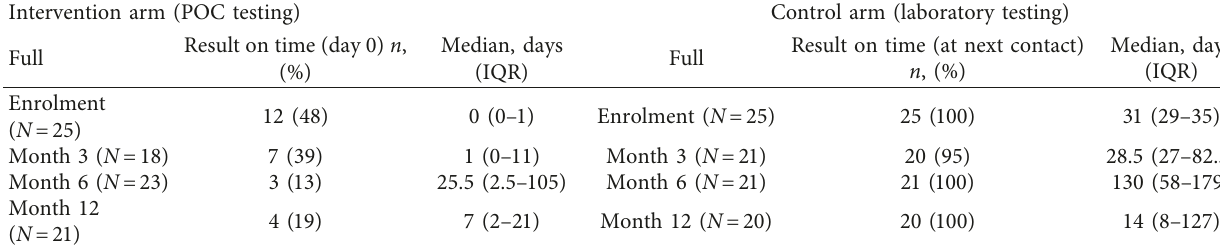
Table 4: Result delivery time per